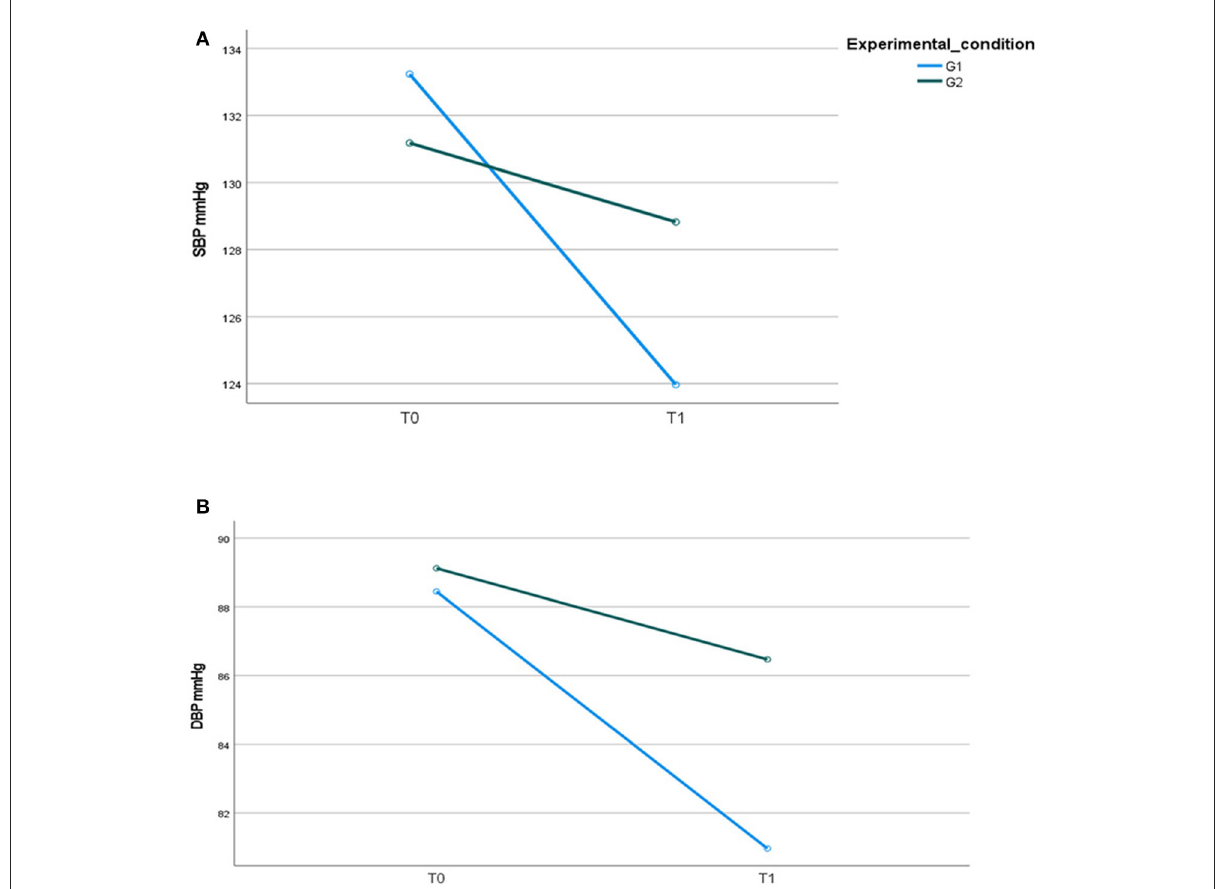
TABLE 4 Physical activity and smoking habits of the participants included in the sample at the time of entry into the study. Participants affected by mental disorders ( n = 51)